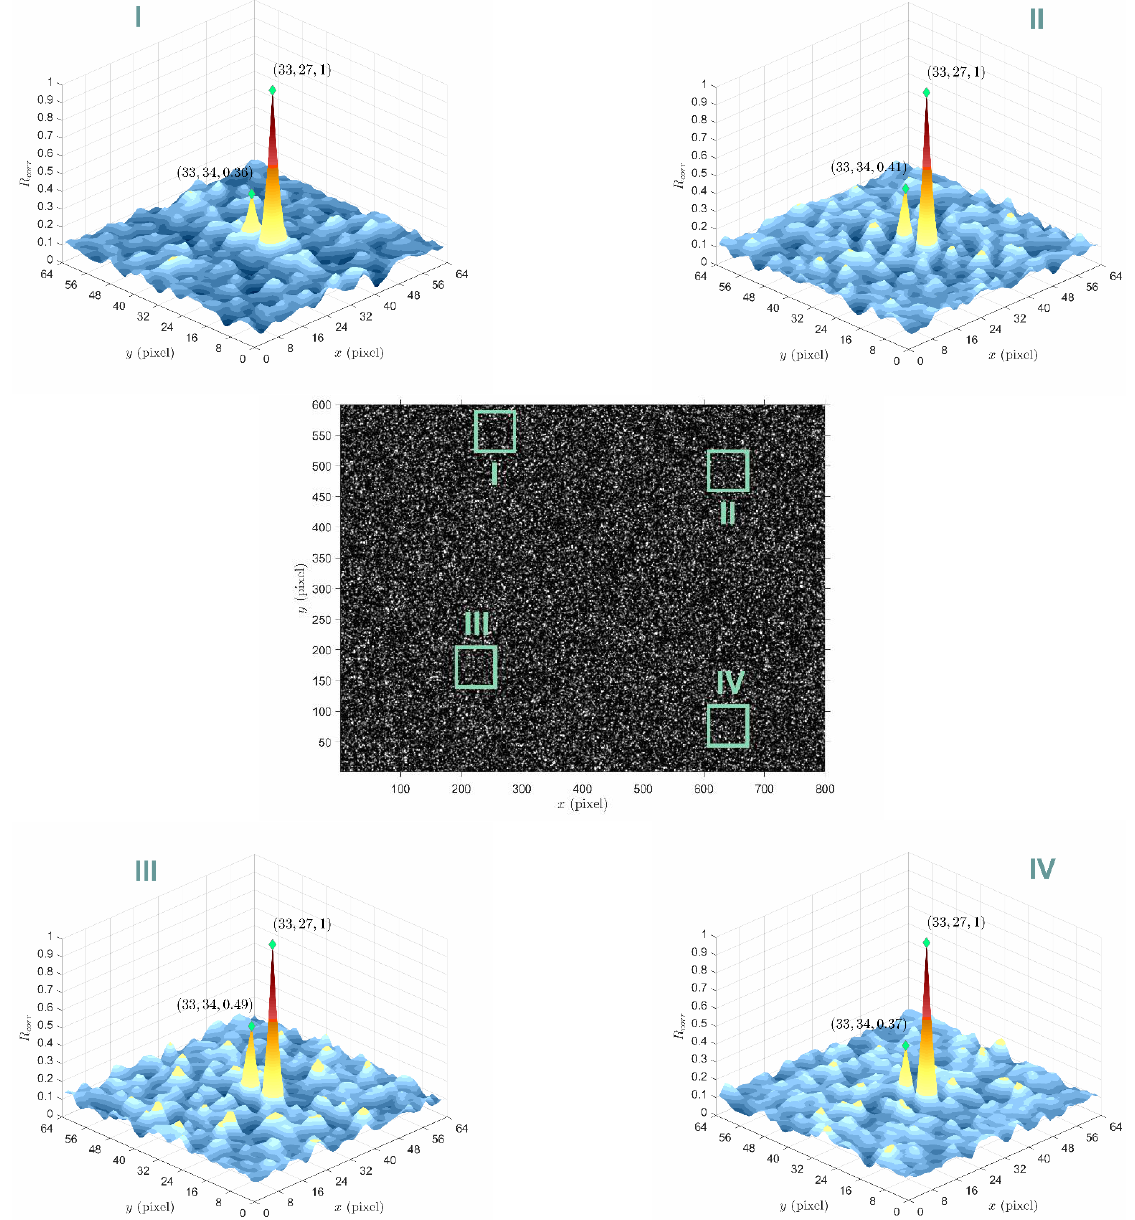
Figure 1. Normalized cross-correlation coefficient ( R corr ) maps of four randomly selected windows with a size of 64 × 64 pixels. Note that the central particle image represents a snapshot of a synthetic stratified crossflow composite of one unidirectional flow moving downward by constant 5 pixels and the other moving upward by constant 2 pixels.